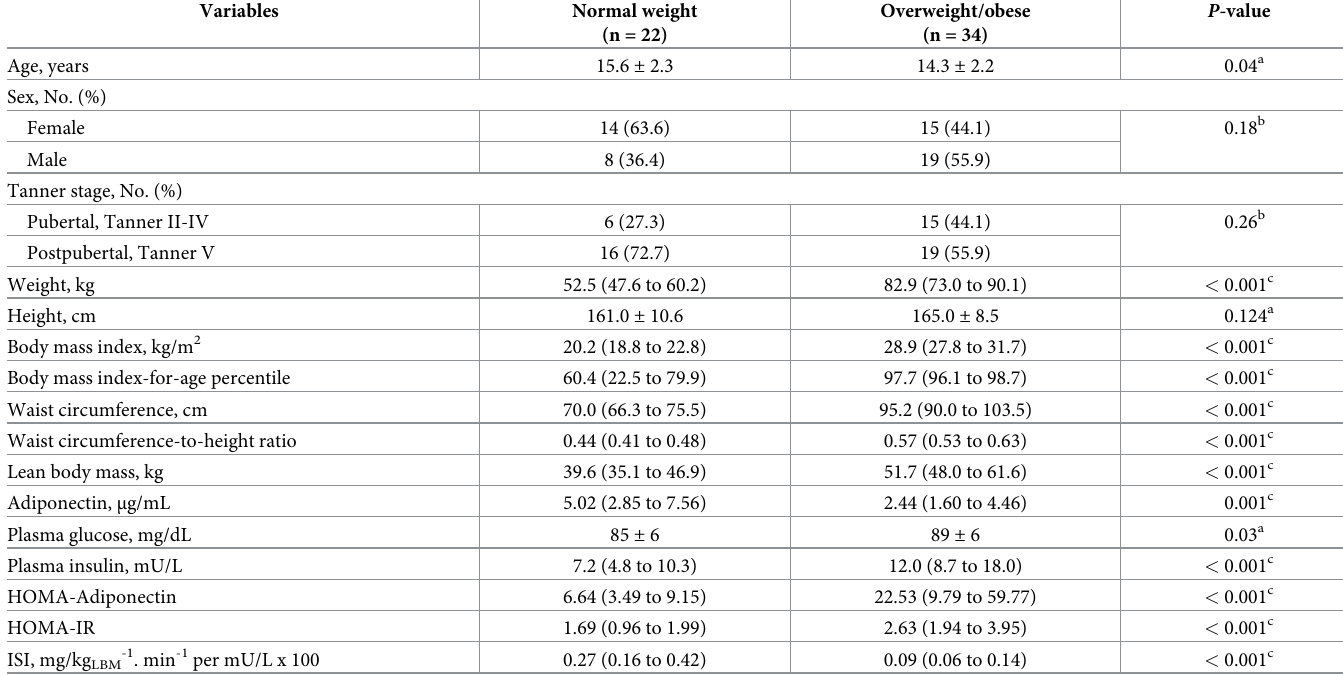
Table 1. Participant